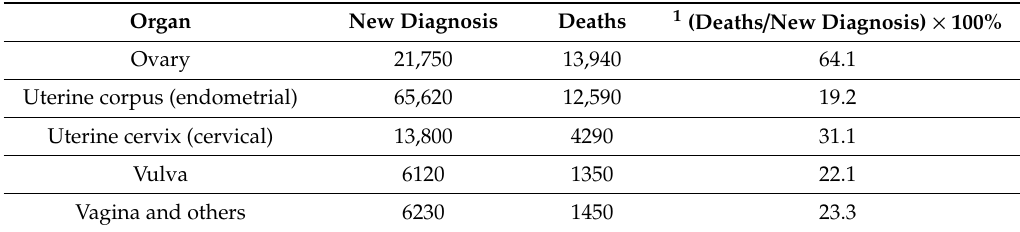
Table 1. Estimated new cases of female gynecologic cancer diagnoses and estimated deaths in the U.S. in 2020. Organ New Diagnosis